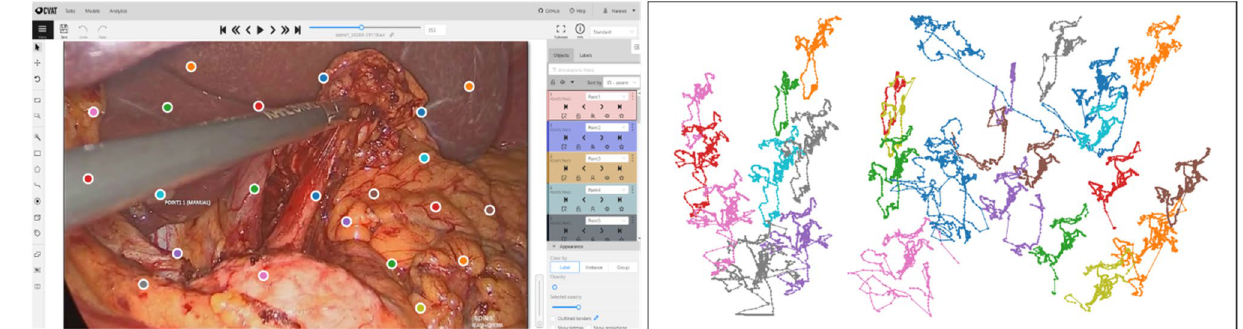
Figure 1. Left: Graphical user interface of CVAT showing a frame with landmark occlusion due to a laparoscopic instrument. Right: Motion paths of the 28 manually annotated landmarks used as ground truth during all 750 frames of the